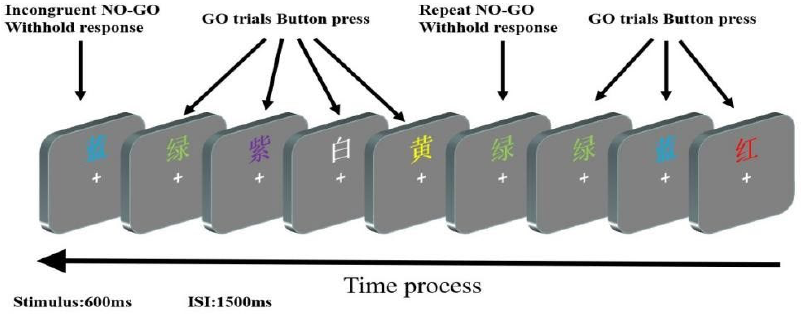
Figure 1. The procedure of the experimental paradigm. “ 蓝 ” = Blue; “ 绿 ” = Green; “ 紫 ” = Purple; “ 白 ” = White; “ 黄 ” = Yellow; “ 红 ” = Red. “ 白 ” = White; “ 黄 ” = Yellow; “ 红 ” =